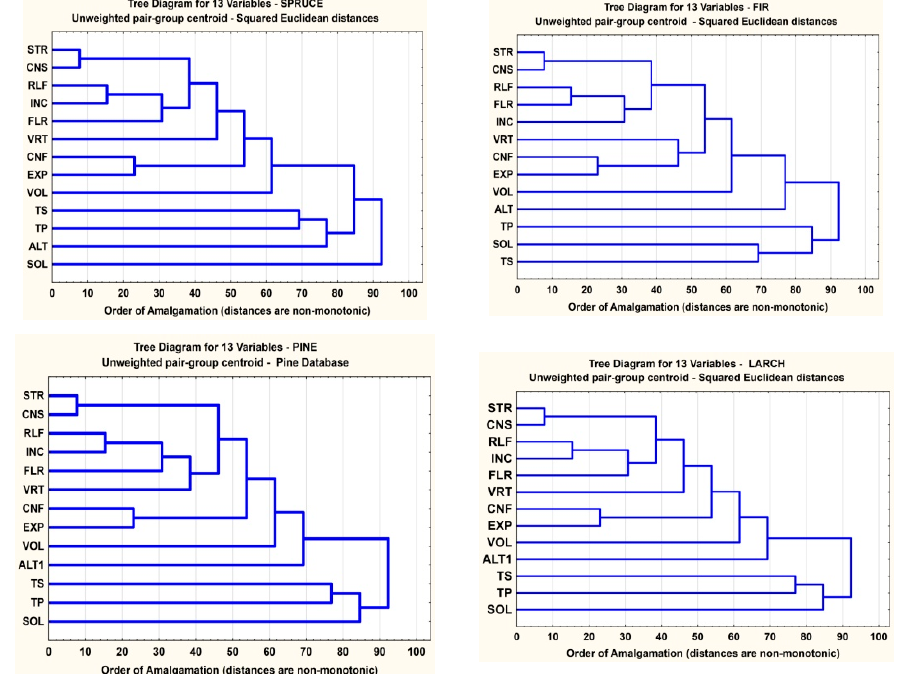
Figure 15. Cluster diagram: unweighted pair-group centroid.